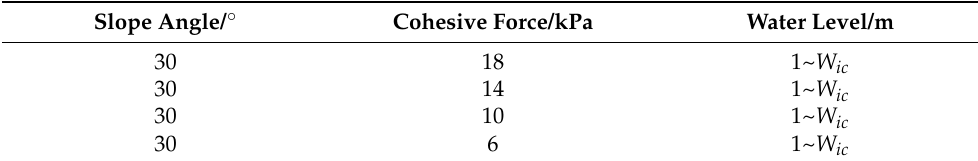
Table 4. Table 4. List of parameters of the model.